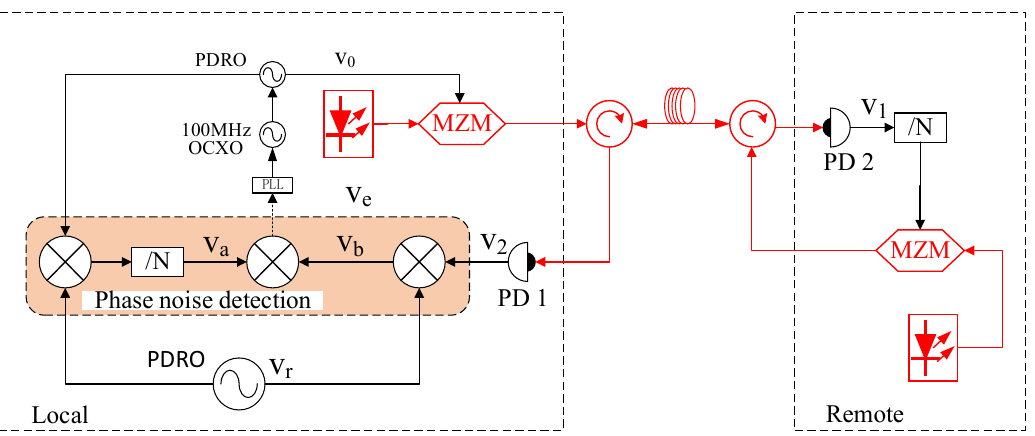
Figure 1. Scheme of the microwave frequency dissemination system; PDRO: phase-lock dielectric resonance oscillator; OCXO: oven-controlled crystal oscillator; MZM: Mach–Zehnder modulator; PD: photodetector.